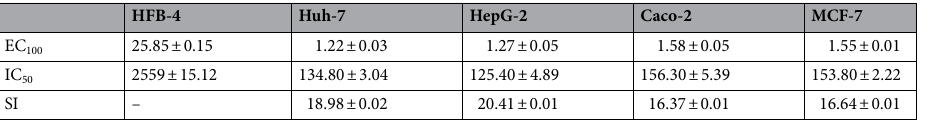
Table 5. EC 100 , IC 50 (μg/mL), and SI values of VGSE against HFB-4, Huh-7, HepG-2, Caco-2, and MCF-7 cell lines after treatment for 48 h. All values were expressed as means ± SD of three experiments. Analysis was achieved using GraphPad Prism software version